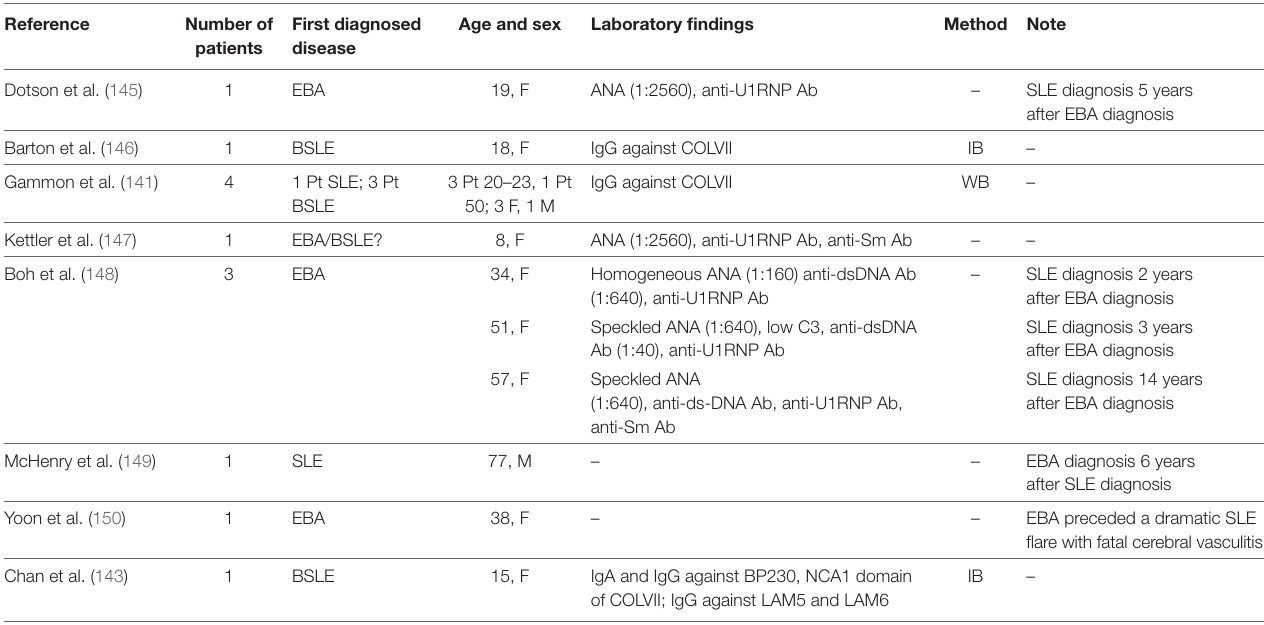
TABLe 2 | Patient showing coexistence of EBA and SLE disease and/or antigens.